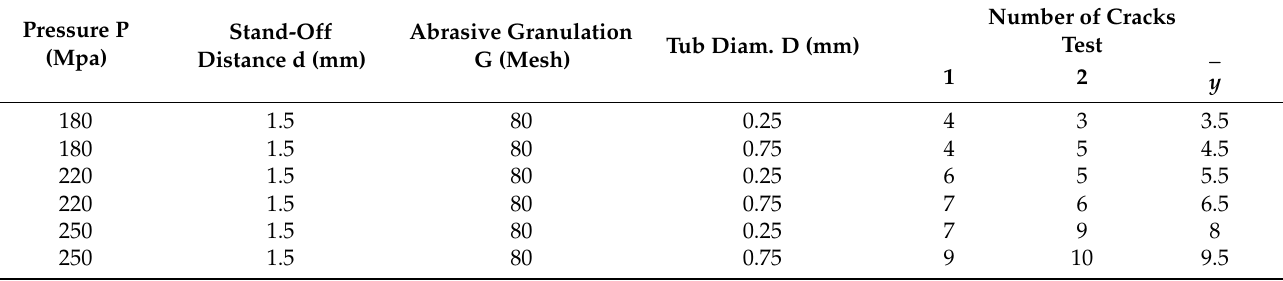
Table 5. Number of cracks depending on pressure and tube diameter.